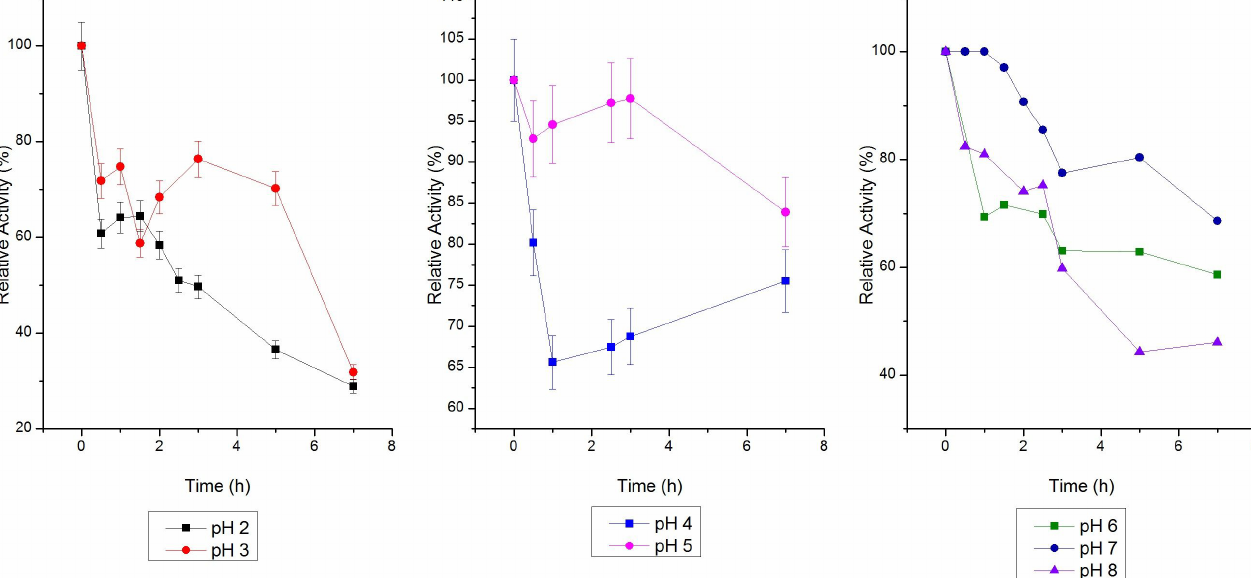
FIGURE 2 - Relative stability of bromelain in several pH at 30 °C. The error bars refer to standard